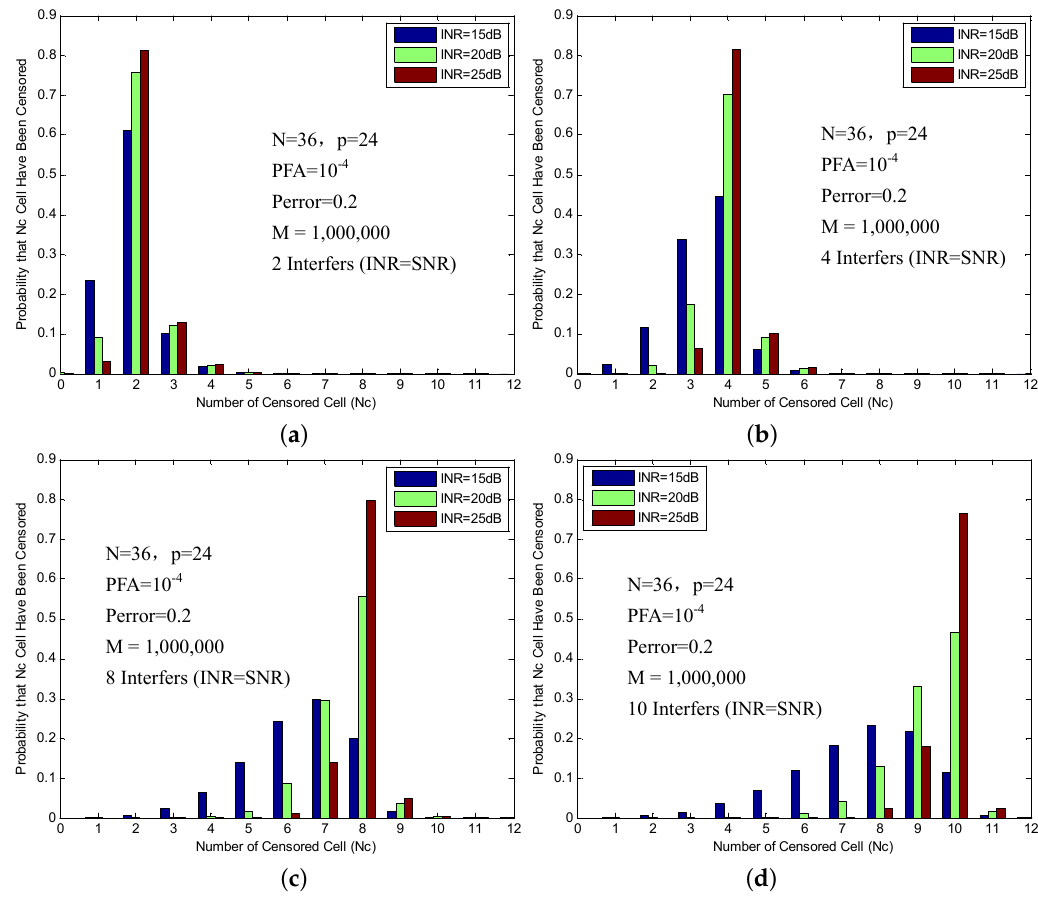
Figure 7. Probability of censoring in multiple target situations: ( a ) Two interference targets; ( b ) Four interference targets; ( c ) Eight interference targets; and ( d ) Ten interference targets.